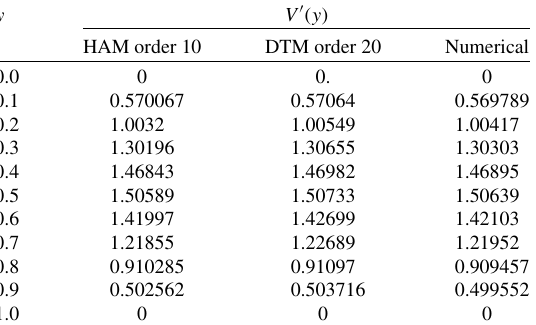
Table 3 Comparison of values of V (cid:2) ( y ) obtained by various orders of the HAM with numerical solution, when Re = 1 . 0 and Ha = 1 . 0